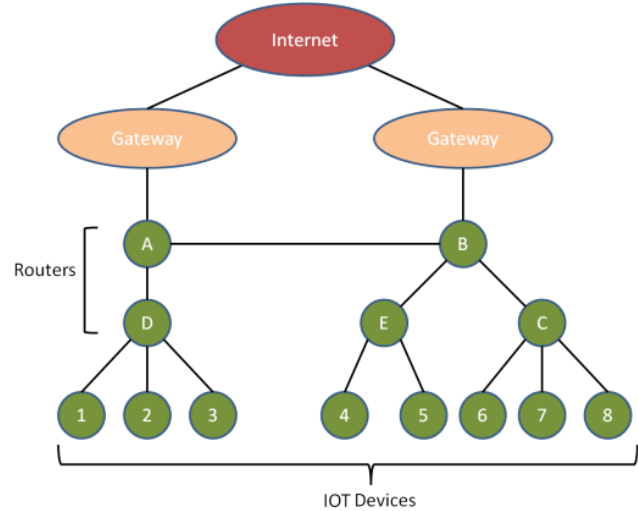
Figure 2. Data flow in cyber-physical system (CPS) network.